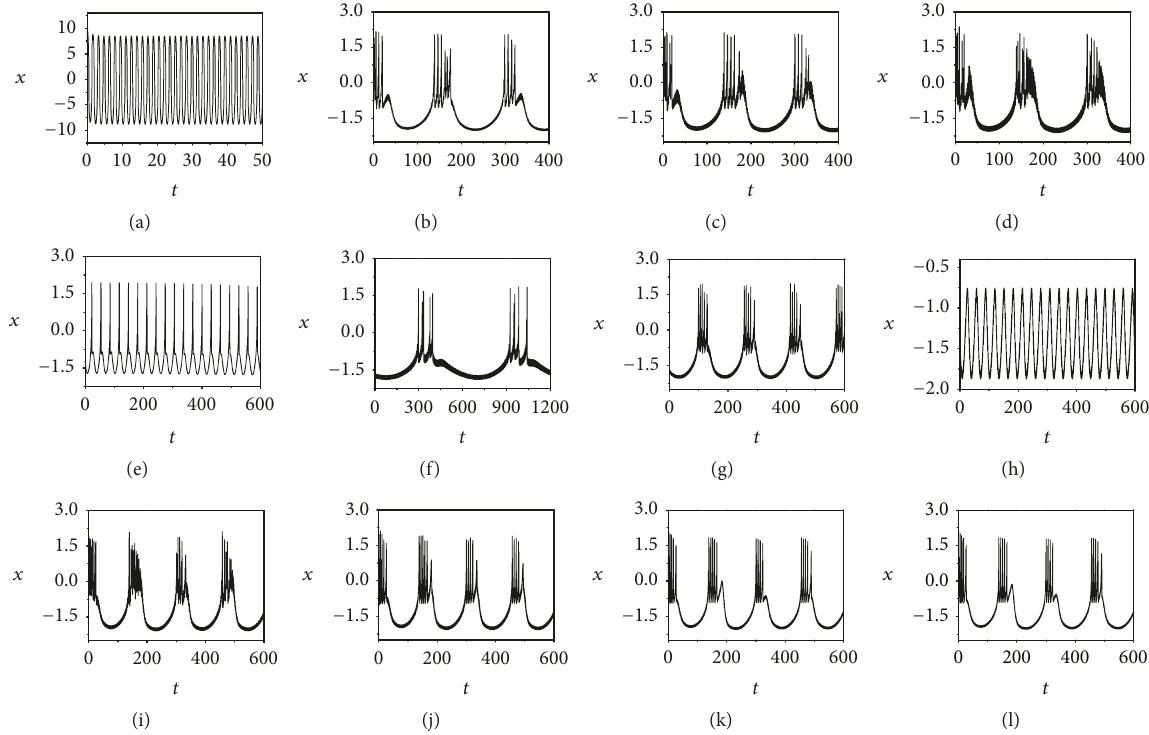
Figure 4: Sampled time series of membrane potential under different parameters. In the first layer, 𝐴 = 1.6 , 𝜔 = 0.04 , 𝑁 = 200 , (a) 𝐵 = 0.1 , (b) 𝐵 = 0.9 , (c) 𝐵 = 1.9 , and (d) 𝐵 = 2.5 . In the second layer, 𝐴 = 𝐵 = 1.6 , 𝑁 = 200 , (e) 𝜔 = 0.001 , (f) 𝜔 = 0.01 , (g) 𝜔 = 0.04 , and (h) 𝜔 = 0.2 . In the last layer, 𝐴 = 𝐵 = 1.6 , 𝜔 = 0.04 , (i) 𝑁 = 100 , (j) 𝑁 = 300 , (k) 𝑁 = 700 , and (l) 𝑁 = 900 . The external high-low frequency current is set as 𝐼 ext = 𝐴 cos (𝜔𝑡) + 𝐵 cos (𝑁𝜔𝑡)